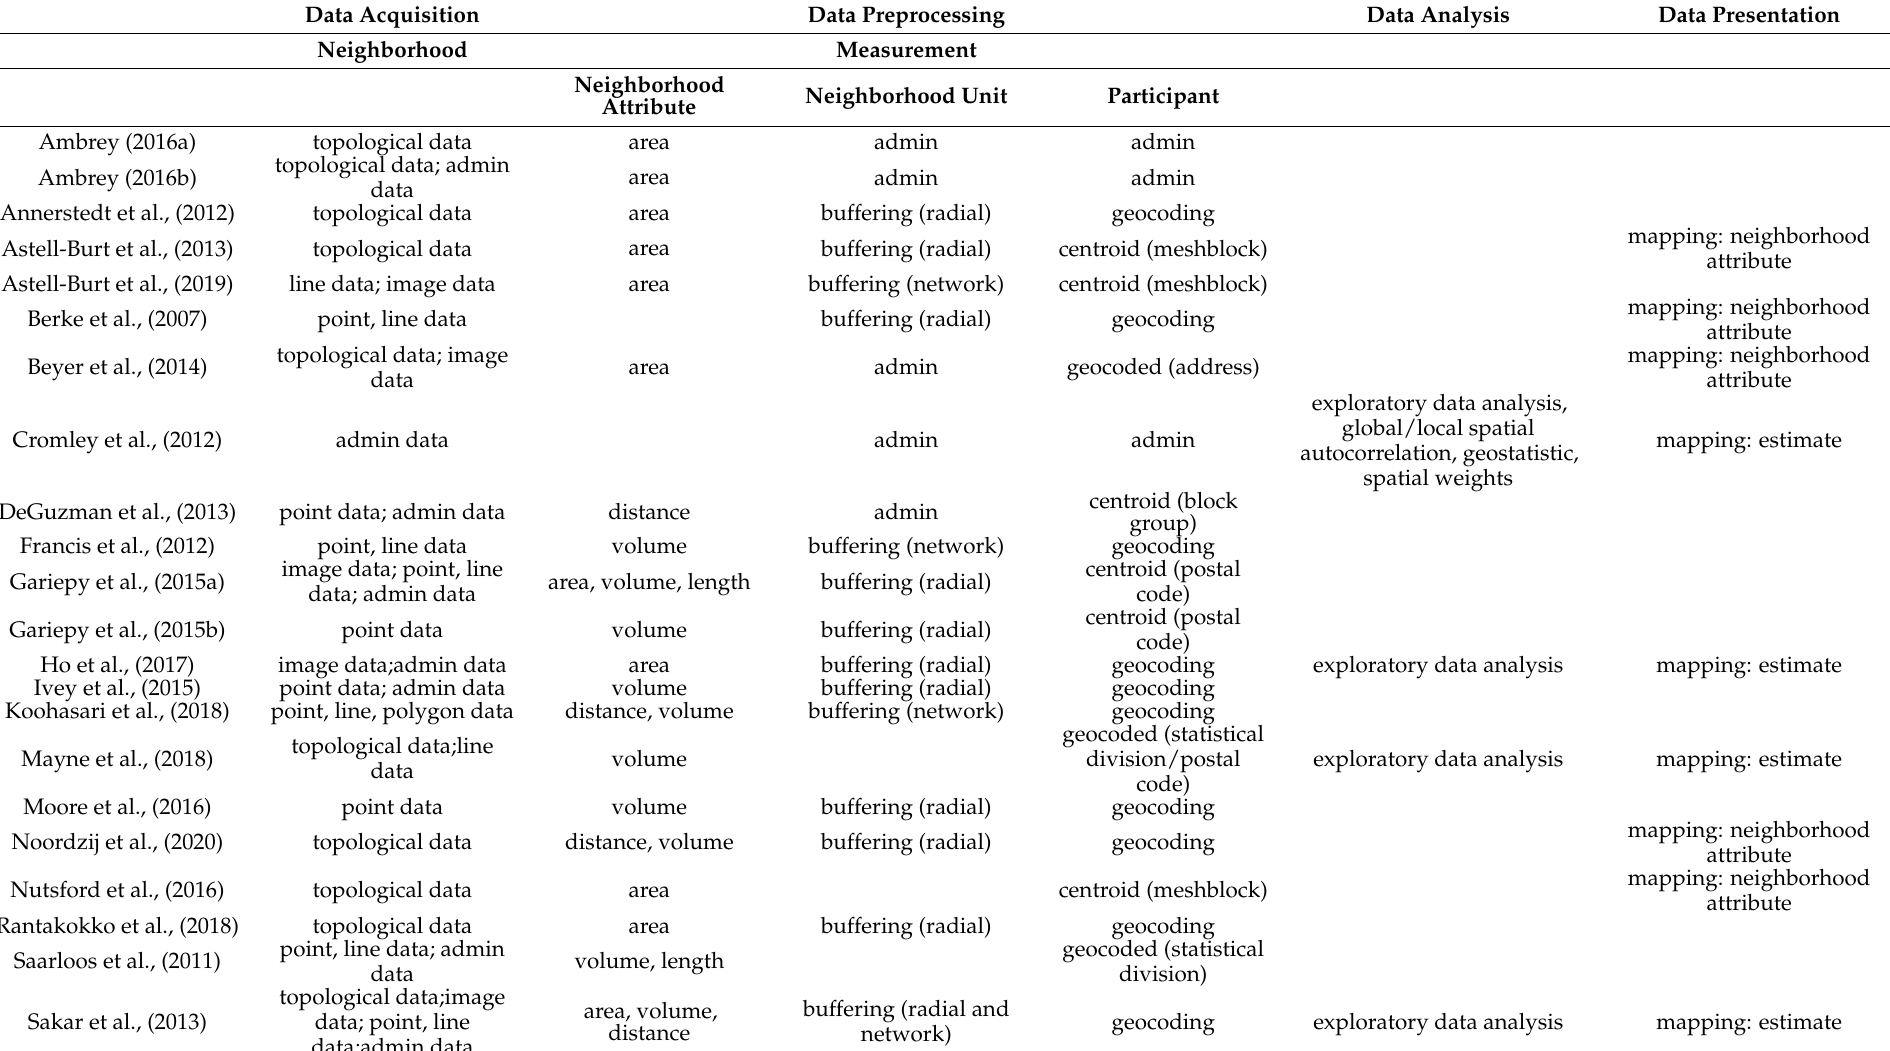
Table 4. Geographic information systems used in selected studies by study design